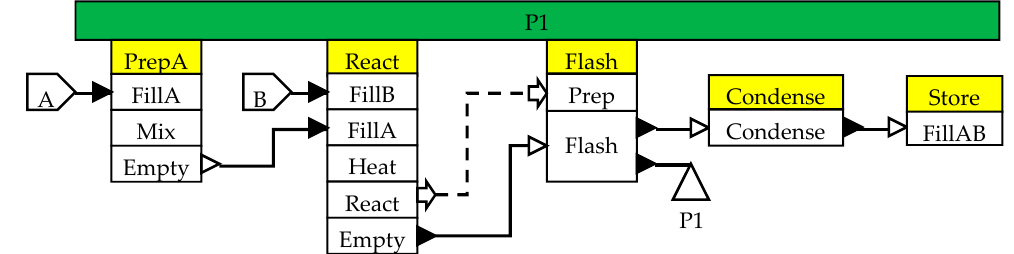
Figure 5. Recipe for manufacture of product P1.